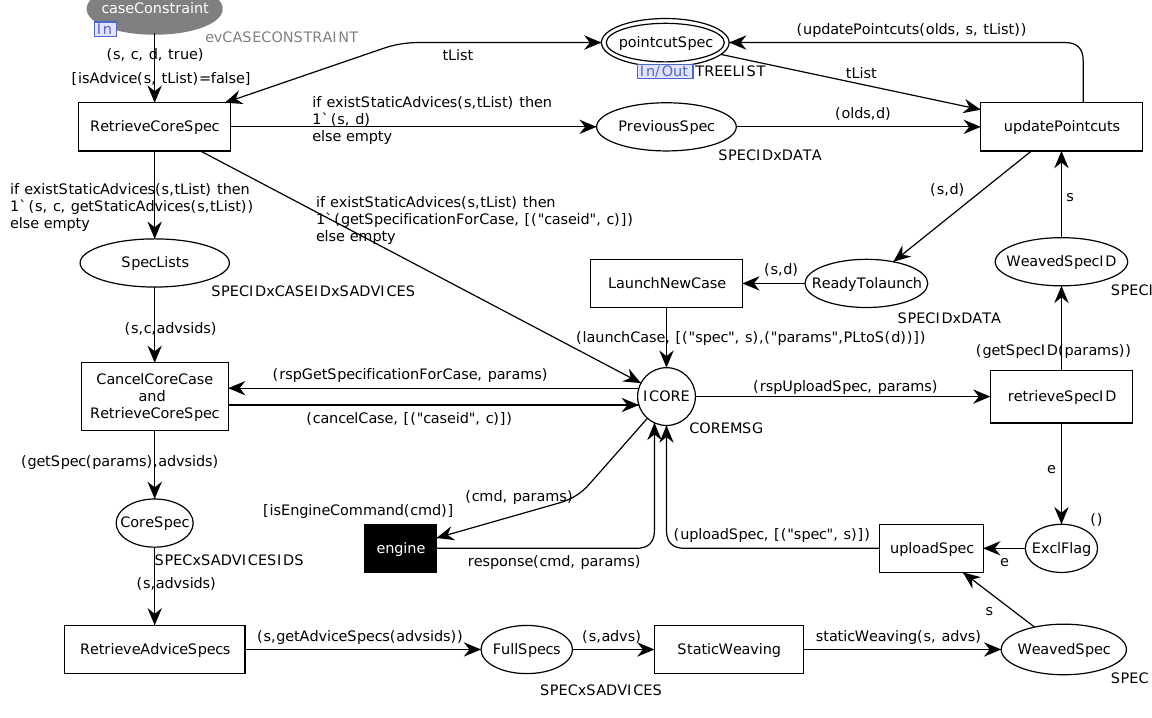
Figure 7. The Configuration steps in Hybrid Weaving